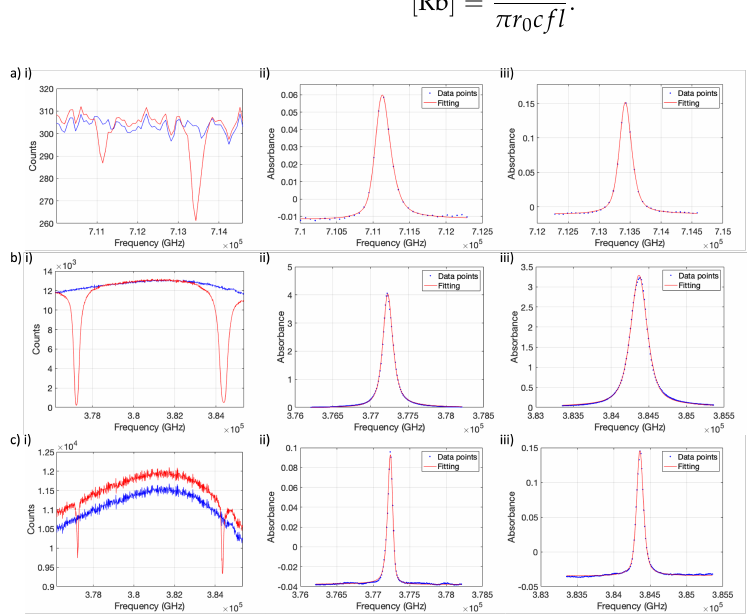
Figure 3. Example absorption spectra. ( a ) Violet and ( b ) NIR spectra acquired with the 1 g Rb cell (Figure 1a), at cell position = + 36cm from the center of the cell, above the Rb source, at oven temperature, T oven ∼ 20 ◦ C, I 0 ( ν ) (blue) and T oven = 145 ◦ C, I ( ν ) (red). Corresponding pseudo-Voigt fitted absorbance spectra for the 5 S 1/2 → ( aii ) 6 P 1/2 , ( aiii ) 6 P 3/2 , ( bii ) 5 P 1/2 (D 1 ), ( biii ) 5 P 3/2 (D 2 ) transitions. Due to the high optical thickness for D 1 and D 2 absorption (deviation from the Beer- Lambert law), the lineshape becomes less well defined and the quality of the fit worsens. ( c ) Example of NIR spectra acquired at cell position = − 36 cm from the center of the cell, away from the Rb source, at T oven ∼ 20 ◦ C I 0 ( ν ) (blue) and T oven = 125 ◦ C, where low [ Rb ] is observed (the Beer-Lambert law is obeyed). The offset between the cold and hot NIR spectra is due to variation when the optical fiber is frequently moved between spectrometers and is accounted for in the baseline fitted parameter, B